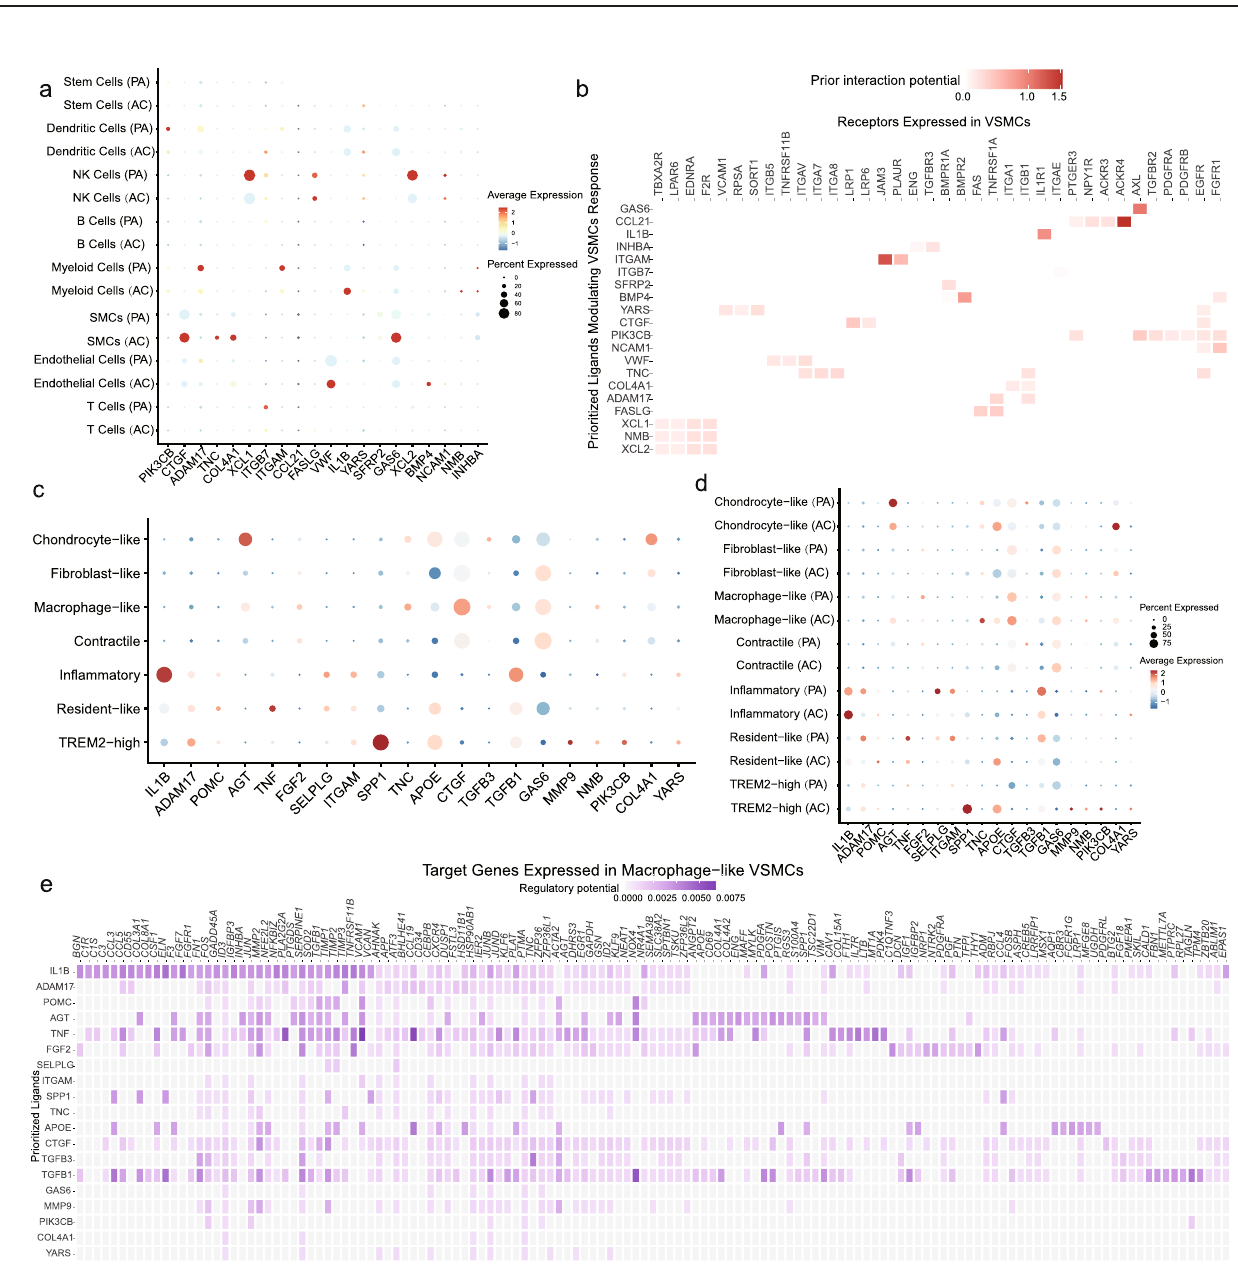
Fig. 4 Transcription factors (TFs) involved in macrophage-like vascular smooth muscle cell (VSMC) differentiation. a Heatmap of macrophage-like VSMC related TFs activities ( n = 127) among different VSMC subtypes. b The macrophage-like associated and differentially expressed TFs were identi fi ed as the intersection of differential expression in macrophage-like VSMC and dysregulation in different atherosclerotic groups. c Heatmap of macrophage- like associated and differentially expressed TFs activities ( n = 52). The top rows represent the transcriptome signature of macrophage-like VSMCs that refer to different state of Monocle and atherosclerotic group (PA and AC). d Boxplots of the 4 signature TFs ( JUN, SMAD3, CBX2 , and ZEB2 ) that upregulated or downregulated in macrophage-like VSMCs and dysregulated between proximal adjacent (PA) and atherosclerotic core (AC) group. e Network showing 52 selected activated (red large diamonds) and repressed (blue large diamonds) TFs in AC group and their target genes (light blue small dots).